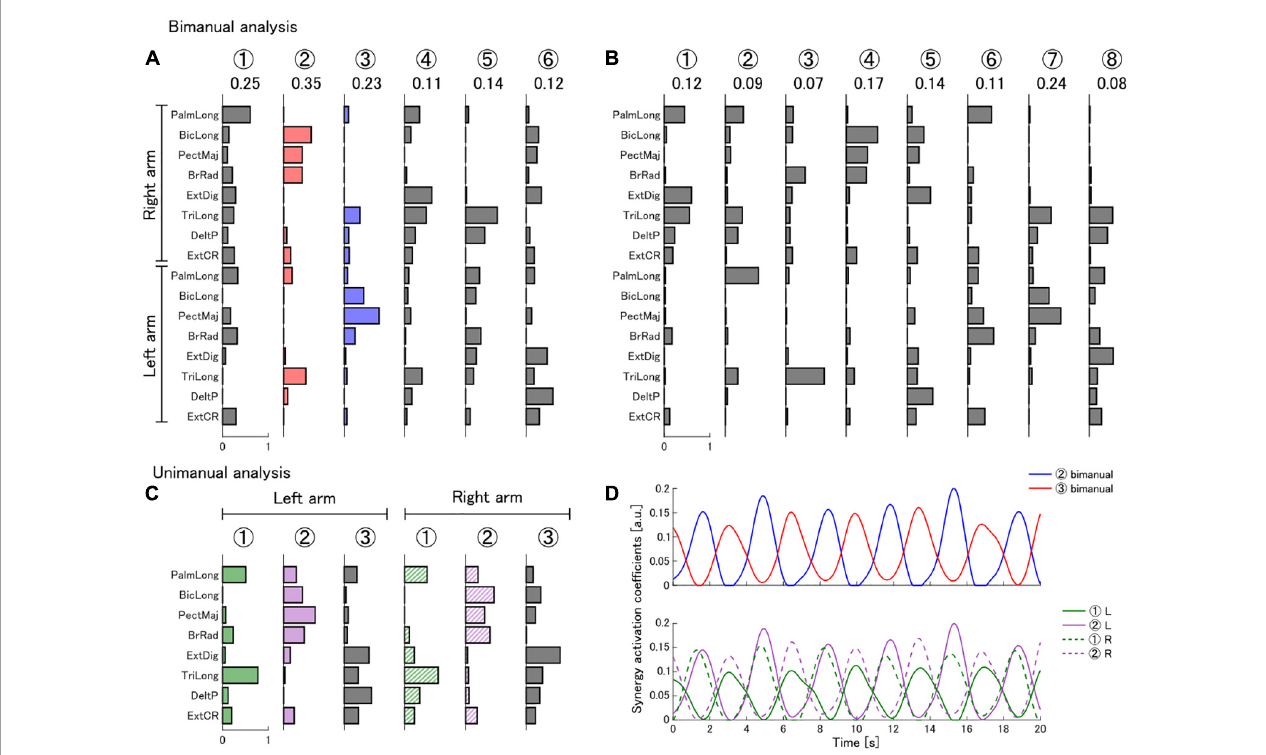
FIGURE2 Muscle synergies extracted from the expert during a real polishing operation. (A) Bimanual muscle synergies extracted according to the synergy selection criteria ( R 2 > 0.90). The number of synergies was determined as N b = 6. Synergies were extracted from the palmaris longus (PalmLong), biceps brachii long head (BicLong), pectoralis major (PectMaj), brachioradialis (BrRad), extensor digitorum (ExtDig), triceps brachii long head (TriLong), deltoid posterior (DeltP), and extensor carpi radialis (ExtCR) muscles of both arms. (B) Bimanual muscle synergies used to compute the EMG similarity score in the virtual polishing task. We selected N EMG = 8 to facilitate improvement in the task. Encircled numbers are labels indicating the synergy number. The value of the synergy importance metric within a synergy set is indicated below each synergy label. (C) Unimanual muscle synergies extracted separately from the left and right arms according to the synergy selection criteria. (D) Muscle synergy activation coefficients of a subset of synergies of the expert during a sample portion of a trial in the real polishing task. The upper and lower panels show the activations of bimanual and unimanual synergies, respectively. The color of the traces indicates the corresponding bimanual or unimanual